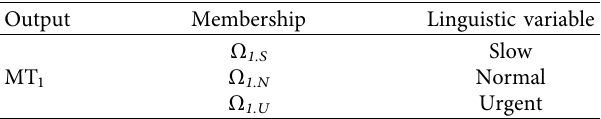
Figure 17: Three-dimensional trapezoidal membership function (MT � f ( q Table 5: Linguistic variables associated with the outputs.